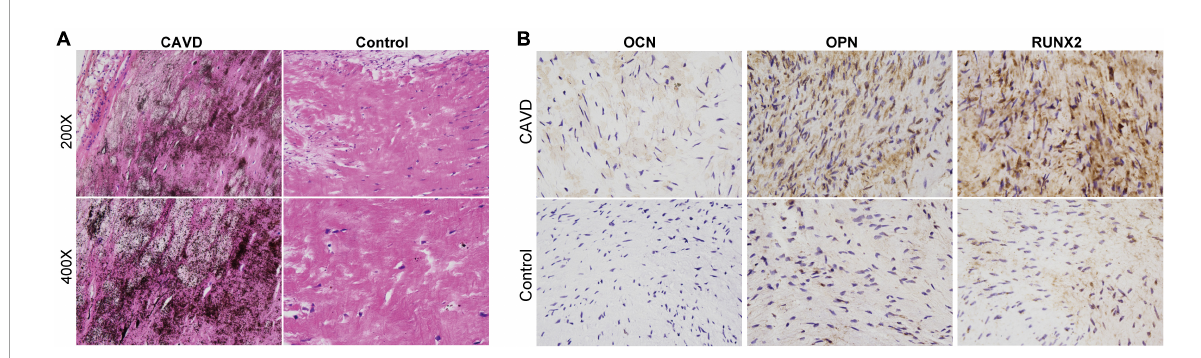
FIGURE1 Histological evaluation of calcium deposition and osteogenic markers in cardiac valves. Representative images of panels (A) von Kossa staining to evaluate calcium deposition and (B) immunohistochemical staining of osteogenic markers in cardiac valve samples.